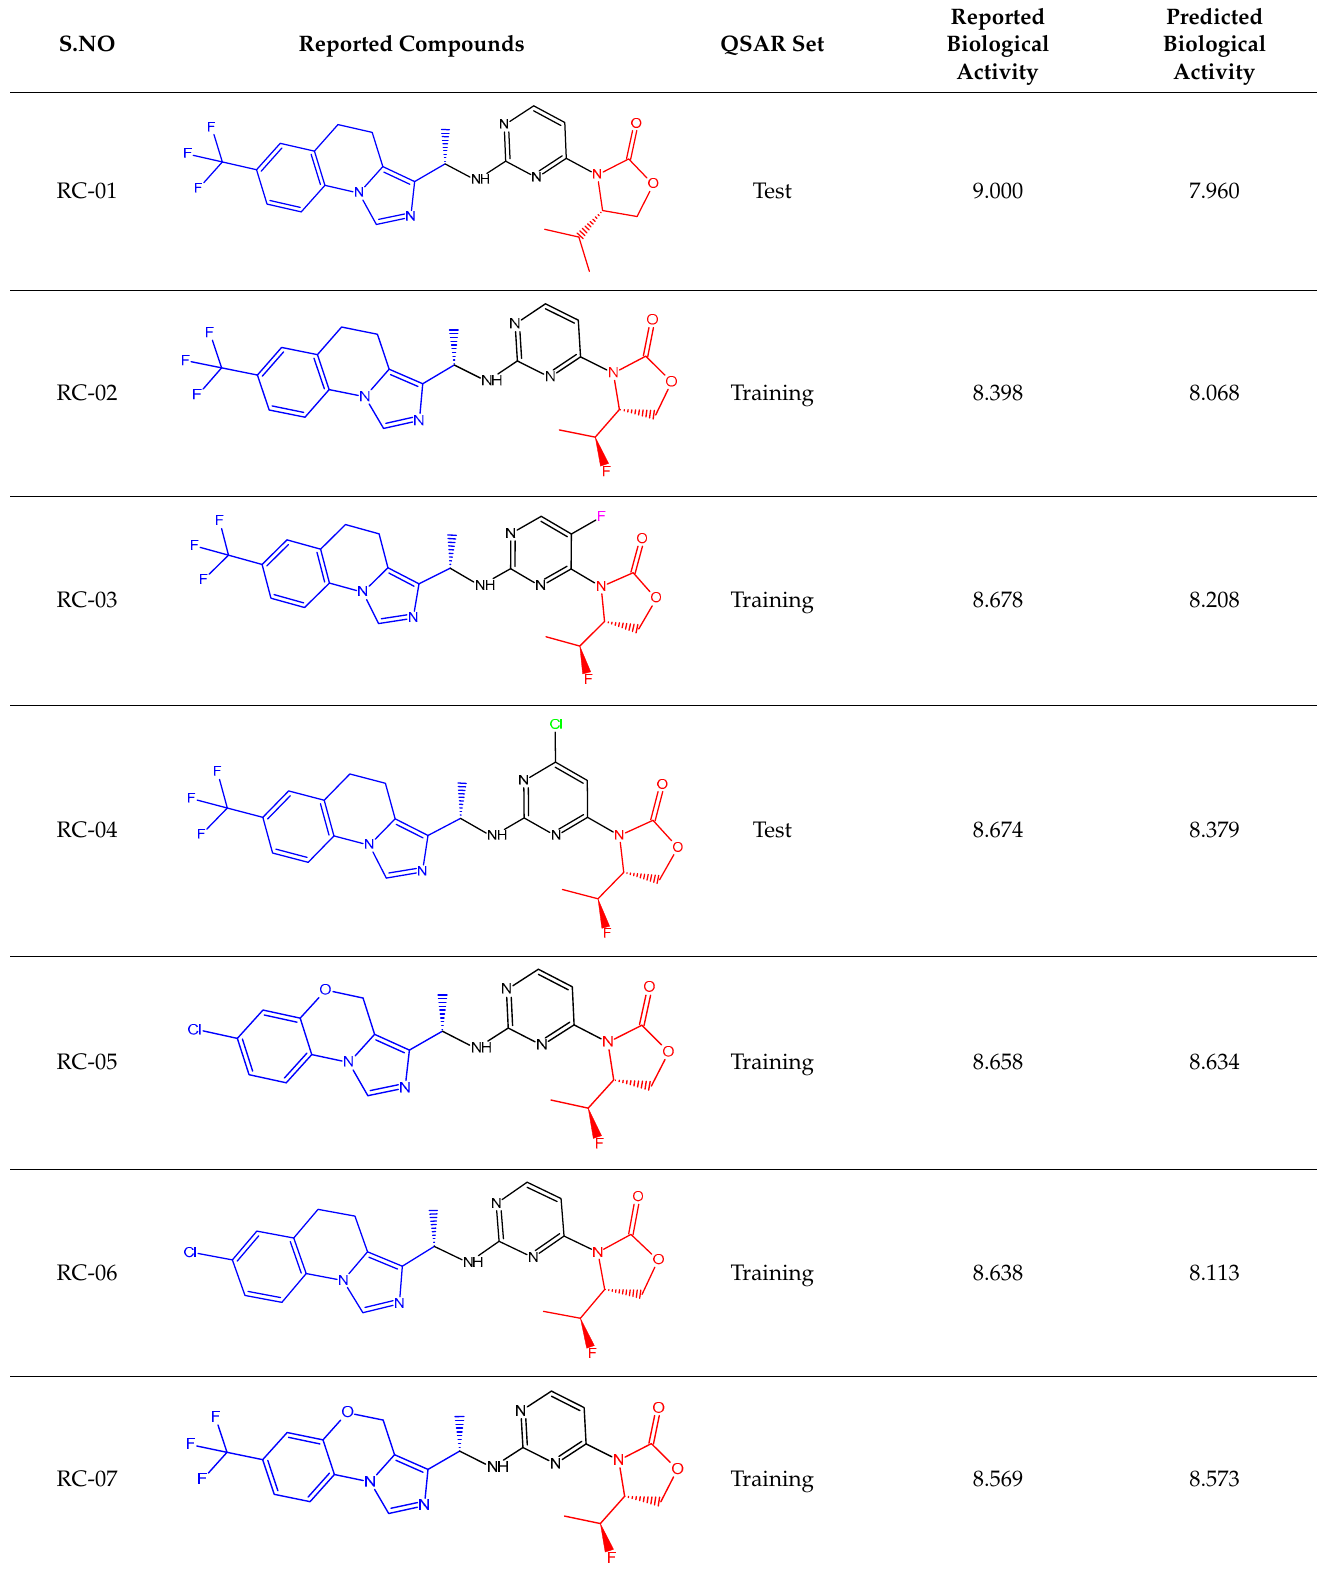
Table 1. Test set and training set compounds with their parameters using FB-3D-QSAR method. S.NO